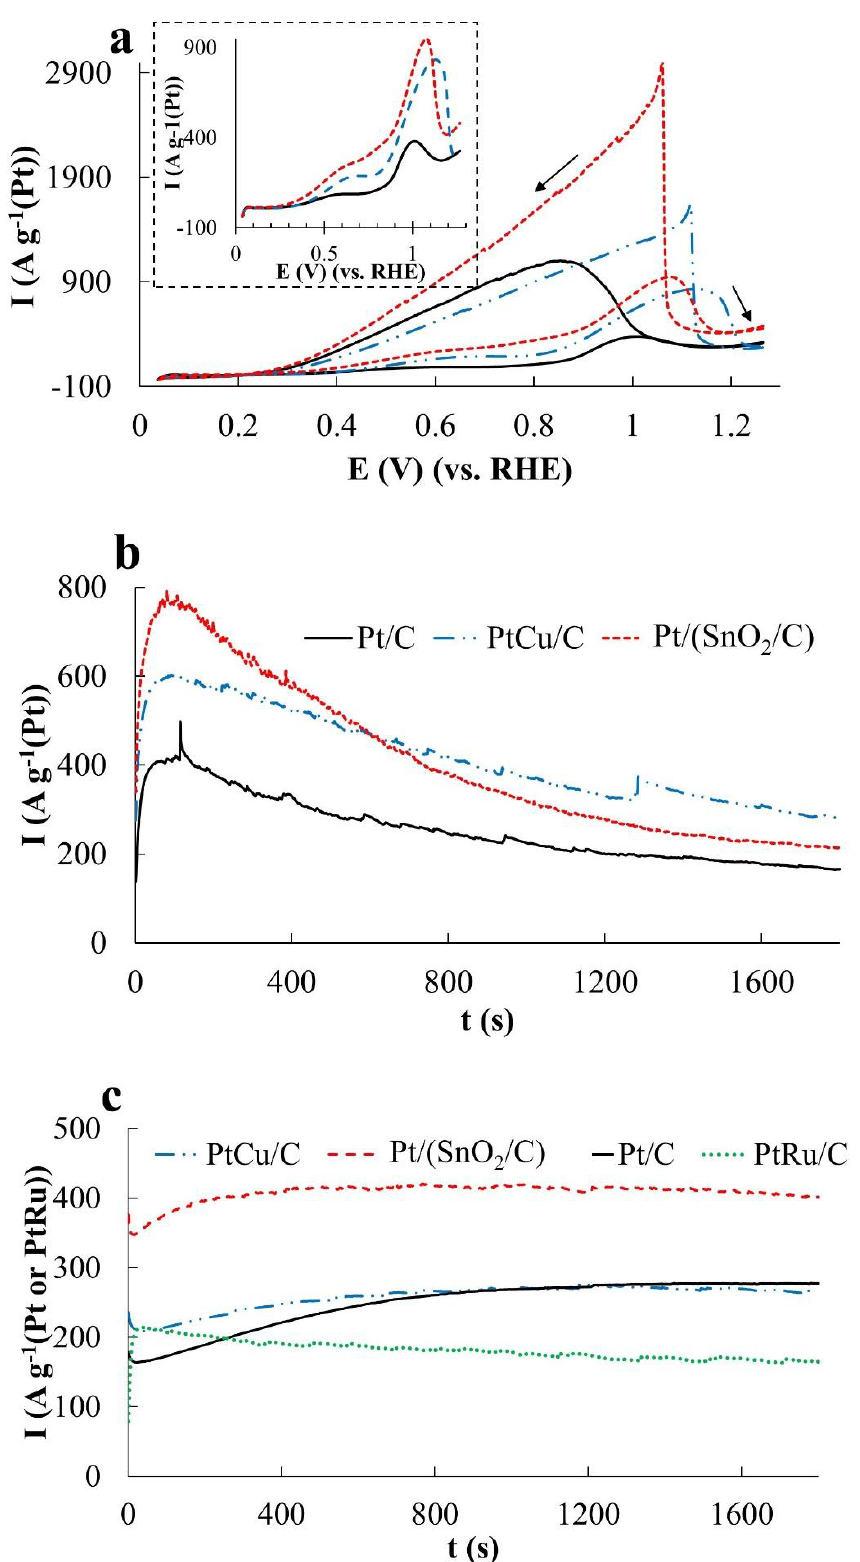
Figure 8. ( a )—Cyclic voltammograms, ( b , c )—chronoamperograms at a potential of 0.87 V ( b ) and 0.60 V ( c ). Electrolyte 0.1 M HClO 4 solution with the addition of 0.5 M HCOOH, saturated Ar at atmospheric pressure. The inset shows the branches of voltammograms corresponding to the forward course of the potential sweep.